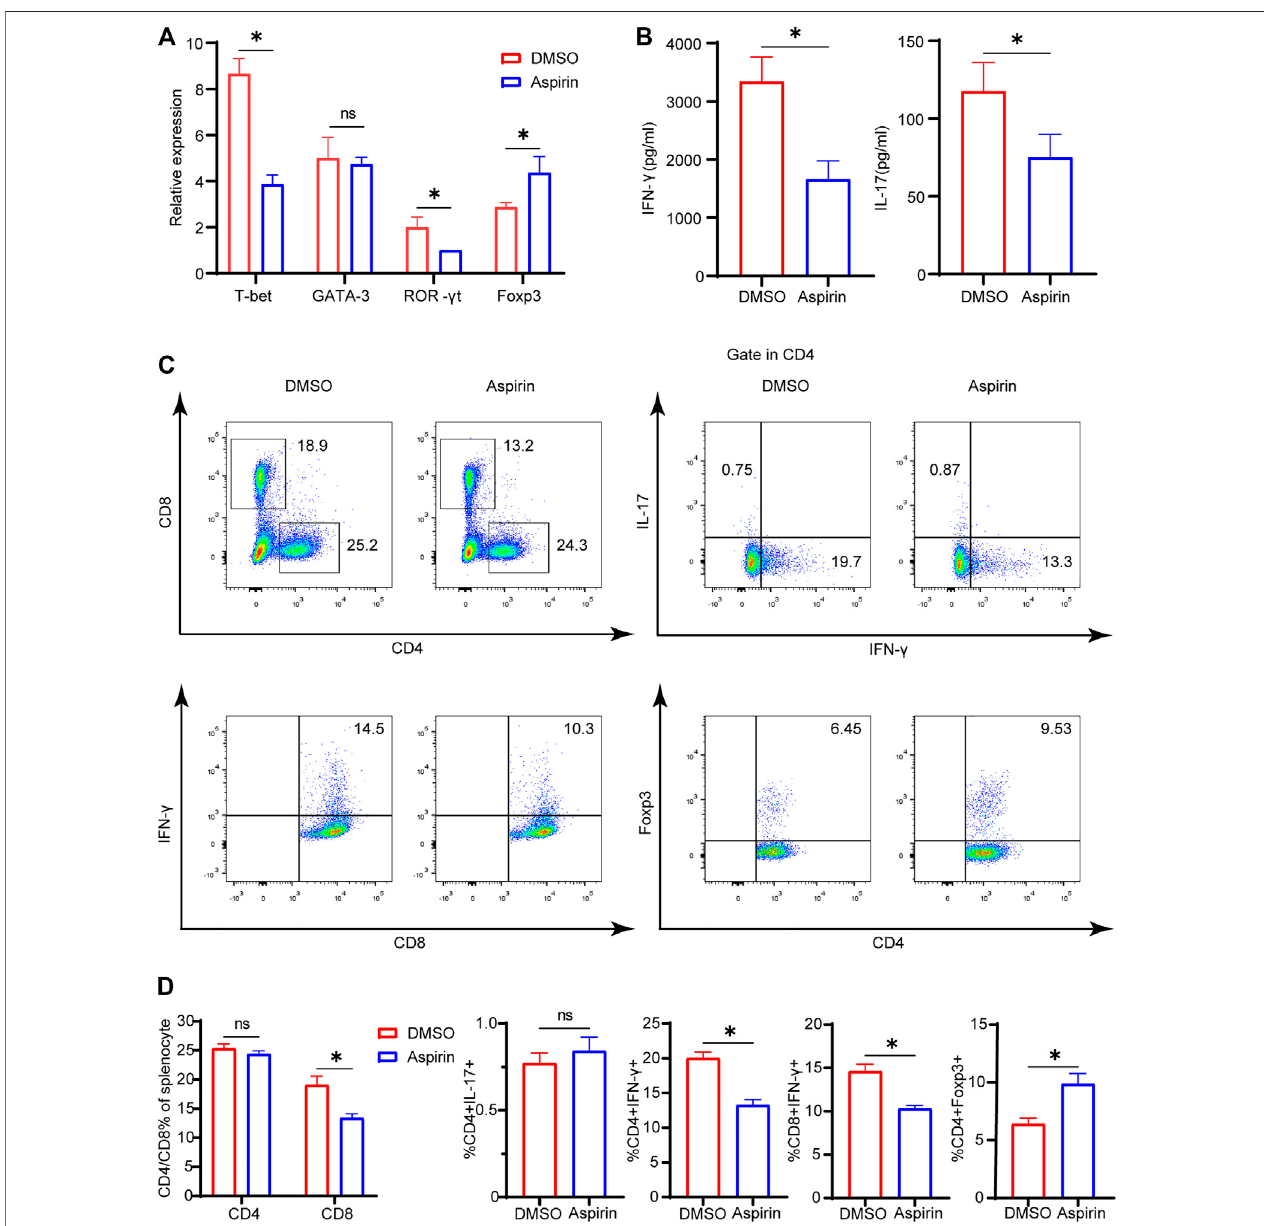
FIGURE 2 | Aspirin alters the composition ofallograft-in fi ltrated T cells and the differentiation ofT cells inthe recipient spleen. Onthe seventhday after transplantation , the spleensand plasmaofrecipientmicewerecollected. (A) ThetotalRNAwasextracted fromspleens ofrecipient mice and reverse-transcribedintocDNA. Transcriptional levelsofT-bet,GATA-3,ROR- γ t,andFoxp3relativetoGAPDHweredetectedbyreal-timePCR. (B) Theplasmaofrecipientmicewasprepared,andtheexpressionlevelsof IFN- γ and IL-17 were determined by ELISA. (C) The spleens of recipient mice from each group were harvested and isolated for antibody staining. The proportion of CD4(+), CD8(+),IFN- γ (+)CD4(+),IL-17(+)CD4(+), Foxp3(+) CD4(+), and IFN- γ (+)CD8(+)cellswas detected by fl owcytometry.The numbers represented the percentages of cells. (D) ThepercentagesofCD4(+),CD8(+),IFN- γ (+)CD4(+),IL-17(+)CD4(+),Foxp3(+)CD4(+),andIFN- γ (+)CD8(+)Tcellsineachgroup.Dataarepresentedasthemean ± SD of four independent experiments. * p < 0.05; GAPDH, glyceraldehyde-3-phosphate dehydrogenase; IL, interleukin; IFN, interferon.